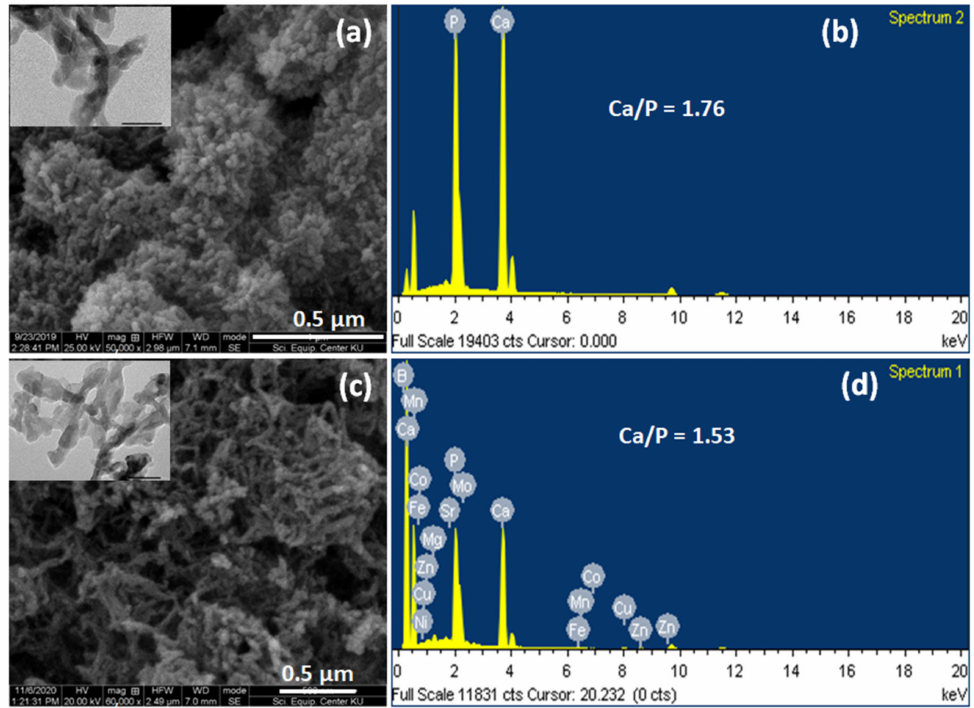
Figure 5. SEM (TEM inset) images ( a ) and EDS analysis ( b ) of sHA particles; ( c , d ) represent SEM (TEM inset) and EDS analysis of THA particles, respectively.